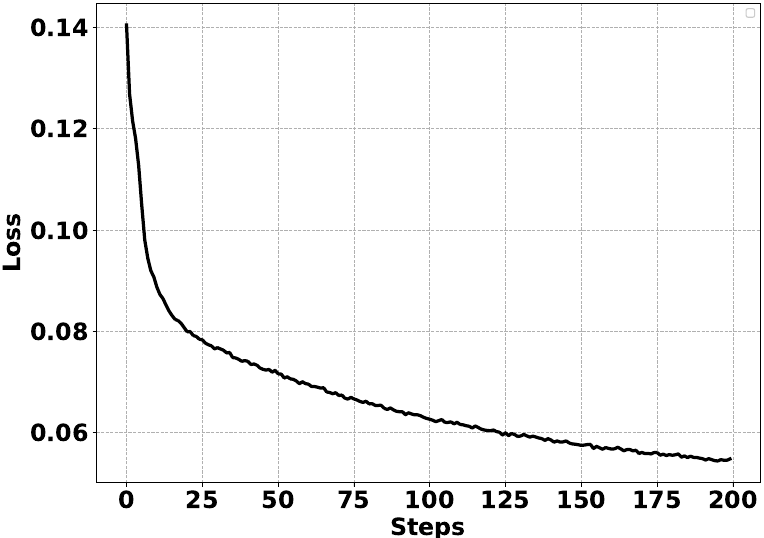
Figure 15. The training loss curve of the proposed LSTM neural network.